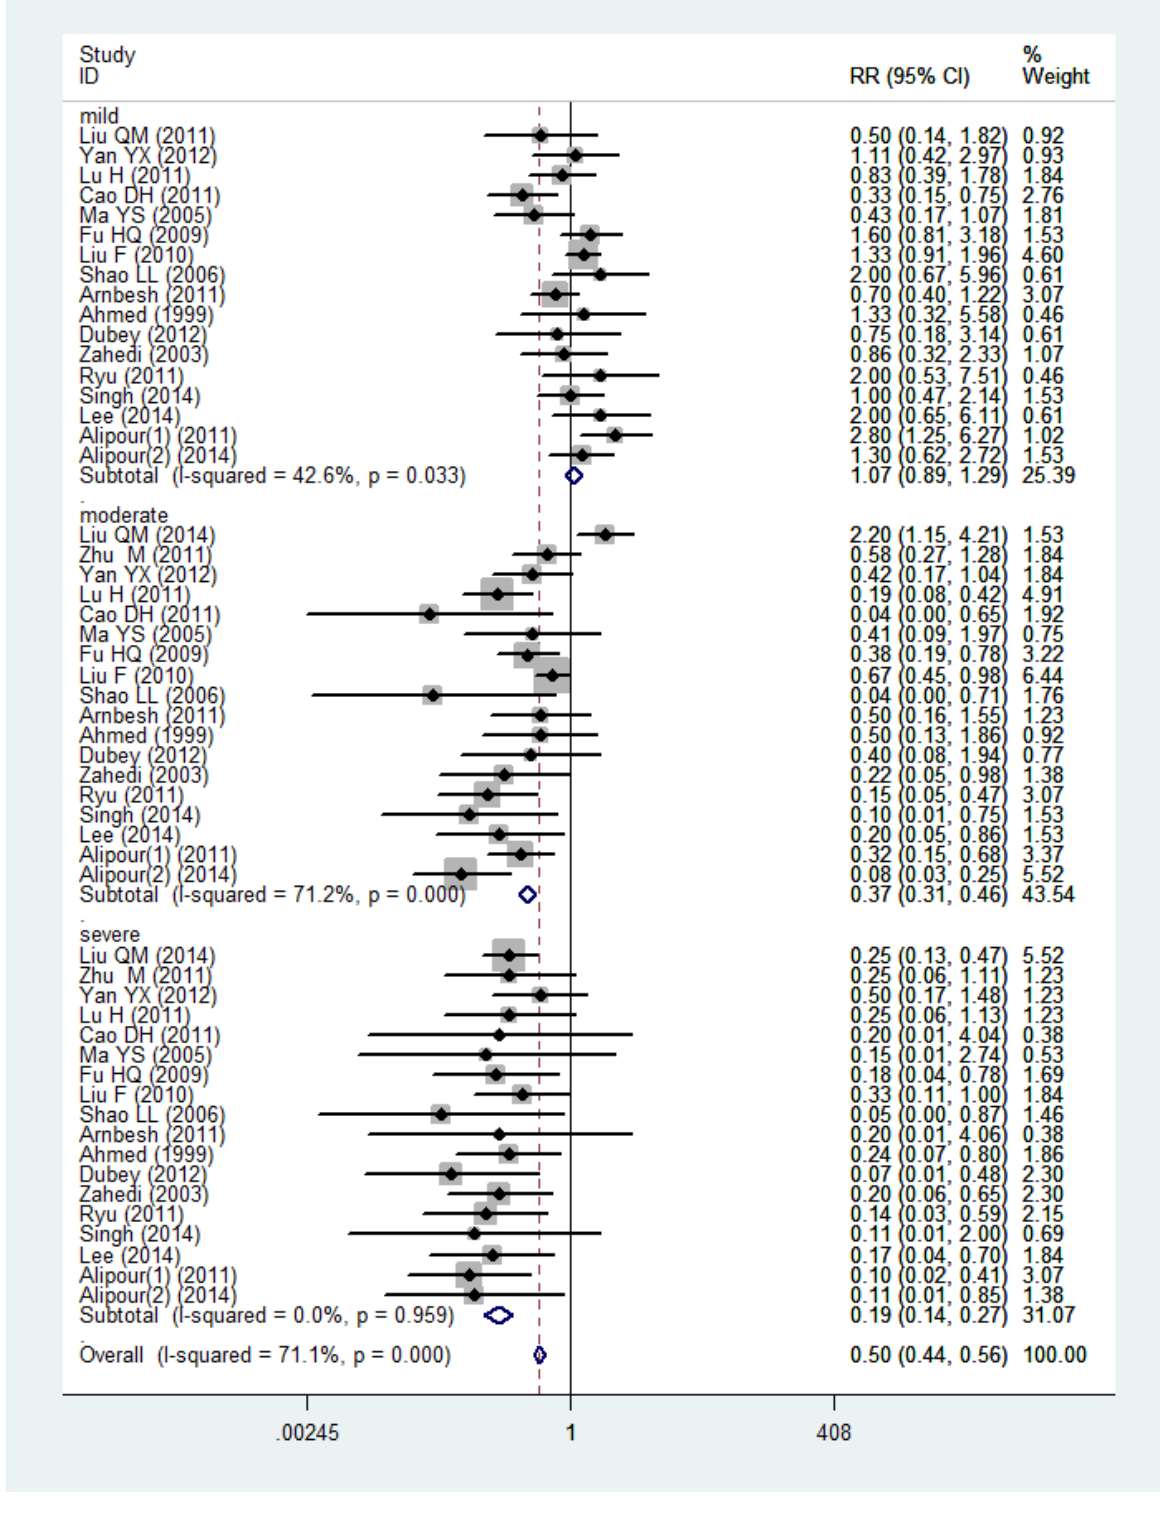
Figure 3: A forest plot of the propofol injection pain incidence between 5-hydroxytryptamine 3 receptor antagonists and control groups according to the pain degree. (RR, risk